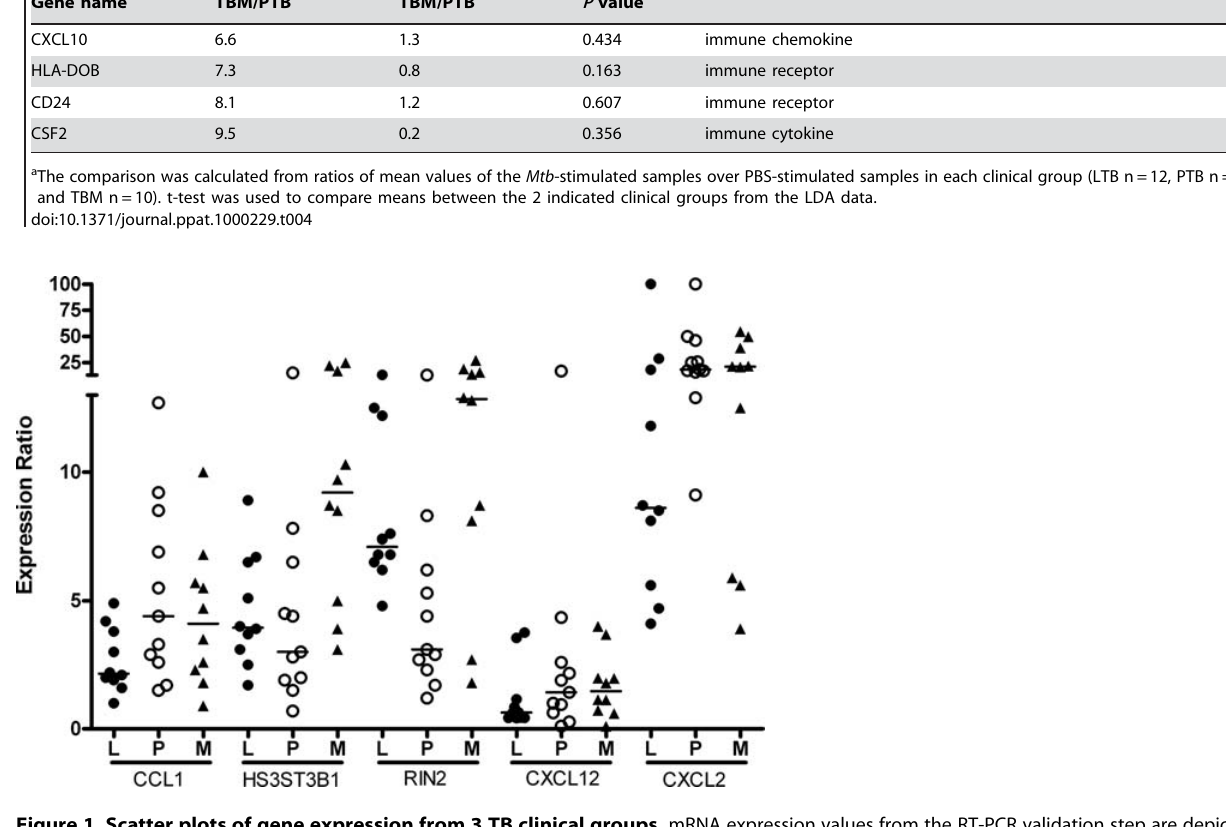
Figure 1. Scatter plots of gene expression from 3 TB clinical groups. mRNA expression values from the RT-PCR validation step are depicted from 5 representative genes (n=34). Expression values are ratios of Mtb -stimulated gene expression in comparison to PBS-stimulation in LTB (dark round), PTB (empty round), and TBM (triangle).